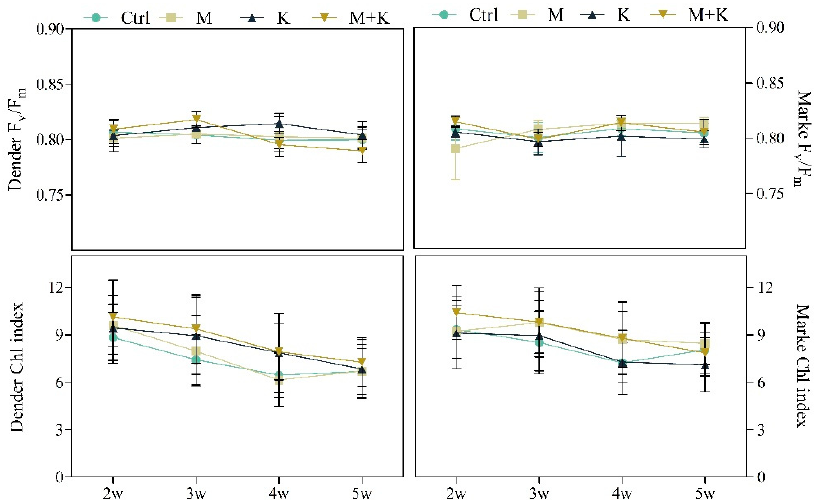
Figure 3. F v /F m and chlorophyll content (Chl index) of leaves of Populus ‘Dender and Populus ‘Marke’ determined during the 4-week experiment. Ctrl (control): Non-inoculated cuttings; M: Methylobacterium sp . CP3 inoculation; K: Kineococcus endophyticus CP19 inoculation; M+K: Methylobacterium sp. CP3 and Kineococcus endophyticus CP19 inoculation . Bars represent ±SD. In Figure 4, shoot and root dry weights of Populus ‘Dender’ and ‘Marke’ are presented. Shoot and roots were collected after 6 weeks of growth in trace element polluted soil. Bacterial inoculation did not have any significant effect on the dry weights of both poplar cultivars.